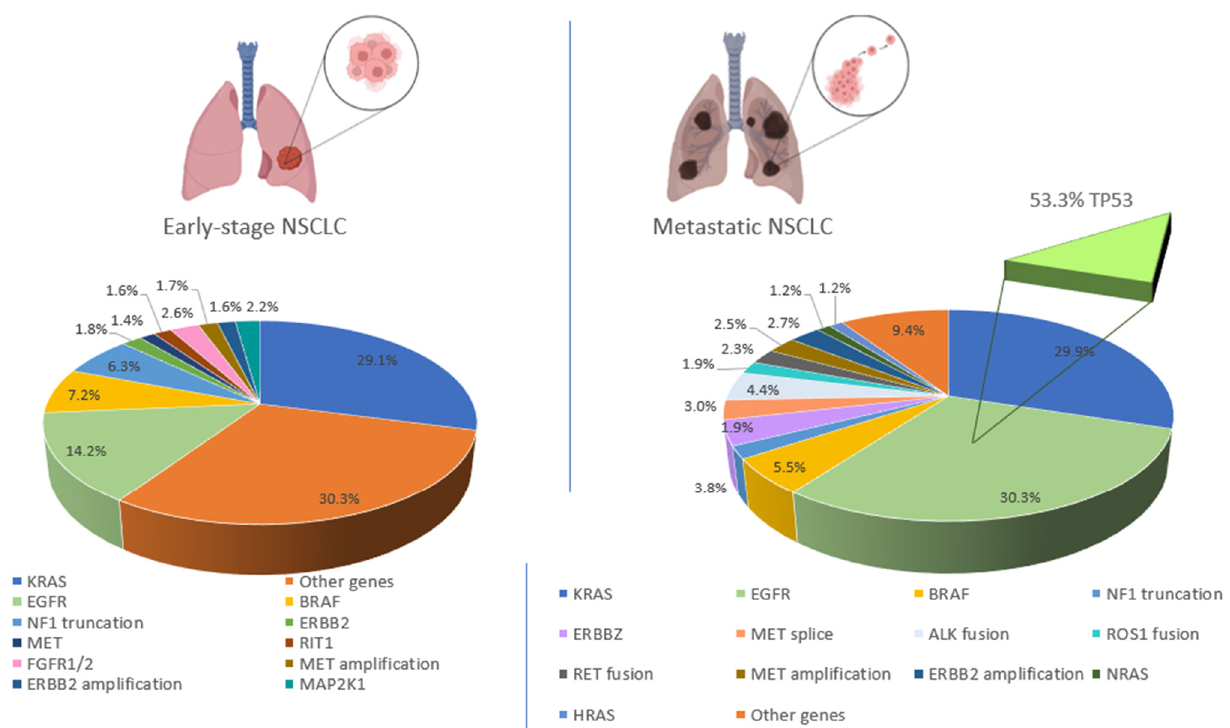
Figure 1. Prevalence of the driver mutations in localized and metastatic non-small cell lung adeno- carcinoma. In the localized, early-stage non-small cell lung adenocarcinoma (left panel) the most prevalent mutations occur within KARS and EGFR genes. Other relevant genes, are BRAF , often mutated with TP 53, LKB 1, ATM , NF 1, PIK 3CA , KEAP 1, MYC and NKX 2-1 and ERBB 2, often mu- tated with NKX 2-1 amplification, ERBB2 itself and in RB1 mutations. Other relevant mutations of prevalence less then 1% are: ( HRAS , NRAS , RET fusion, ROS 1 fusion and ALK fusion for early-stage NSCLC and RIT 1, FGFR 1 or FGFR 2 and MAP 2K1 mutations for metastatic NSCLC). Some mutations, which have a low prevalence in the early stages, become more significant in metastatic settings ( right panel), these mutations include EGFR , ALK , ROS 1 and RET fusions and MET splice mutations. ALK rearrangements, as well as ROS 1 and RET fusions, often co-occur with CDKN 2A (32.5%) and CDKN 2B (26.5%) mutations. MET exon 14 skipping is usually co-mutated with MDM 2 and CDK 4 amplification. In EGFR -mutated sub-group, the most common co-driver mutation is in TP 53 gene (53.3%). Only mutations with a prevalence higher than 1% are shown in the picture. Data